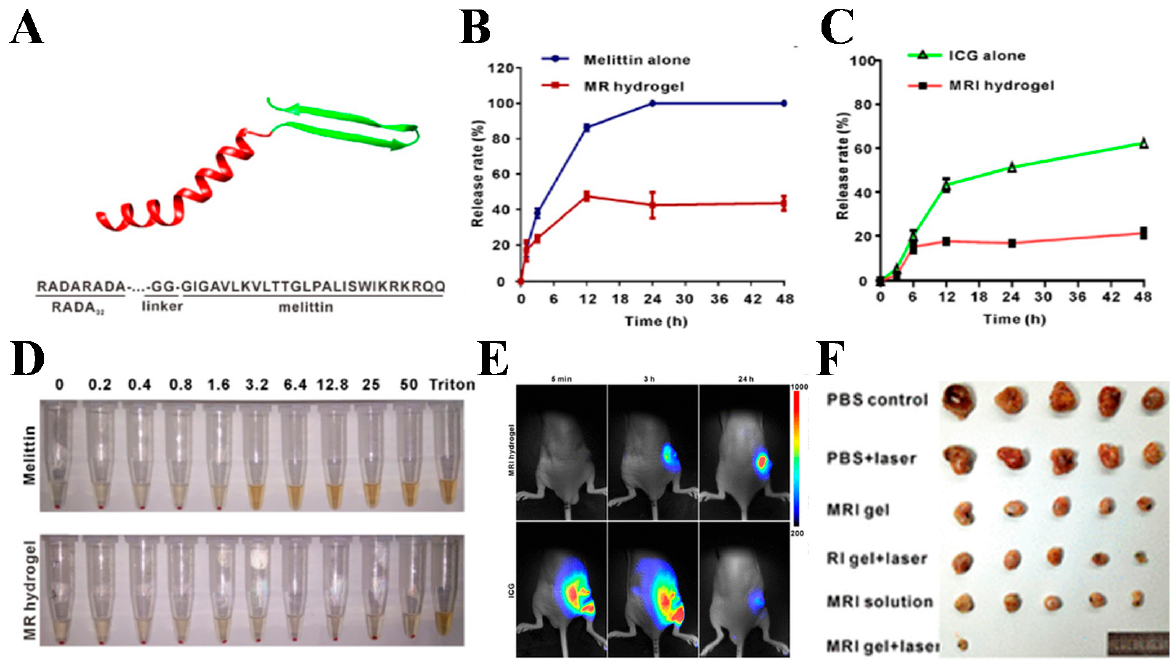
Figure 3. ( A ) Diagram of the molecular structure of the RADA 32 − melittin fusion peptide; ( B ) comparison of the melittin release profile between the MRI hydrogel and melittin solution over a period of 2 days; ( C ) comparison of the ICG release profile between the MRI hydrogel and ICG solution over a period of 2 days; ( D ) evaluation of the hemolysis effect of the MRI hydrogel and free melittin; ( E ) fluorescence imaging of MRI hydrogel and ICG solution biodistribution at 5 min, 3 h, and 24 h post-intratumoral injection; ( F ) evaluation of the in vivo antitumor efficacy of the MRI hydrogel. Reprinted with permission from Ref. [54]. Copyright 2017, American Chemical Society.